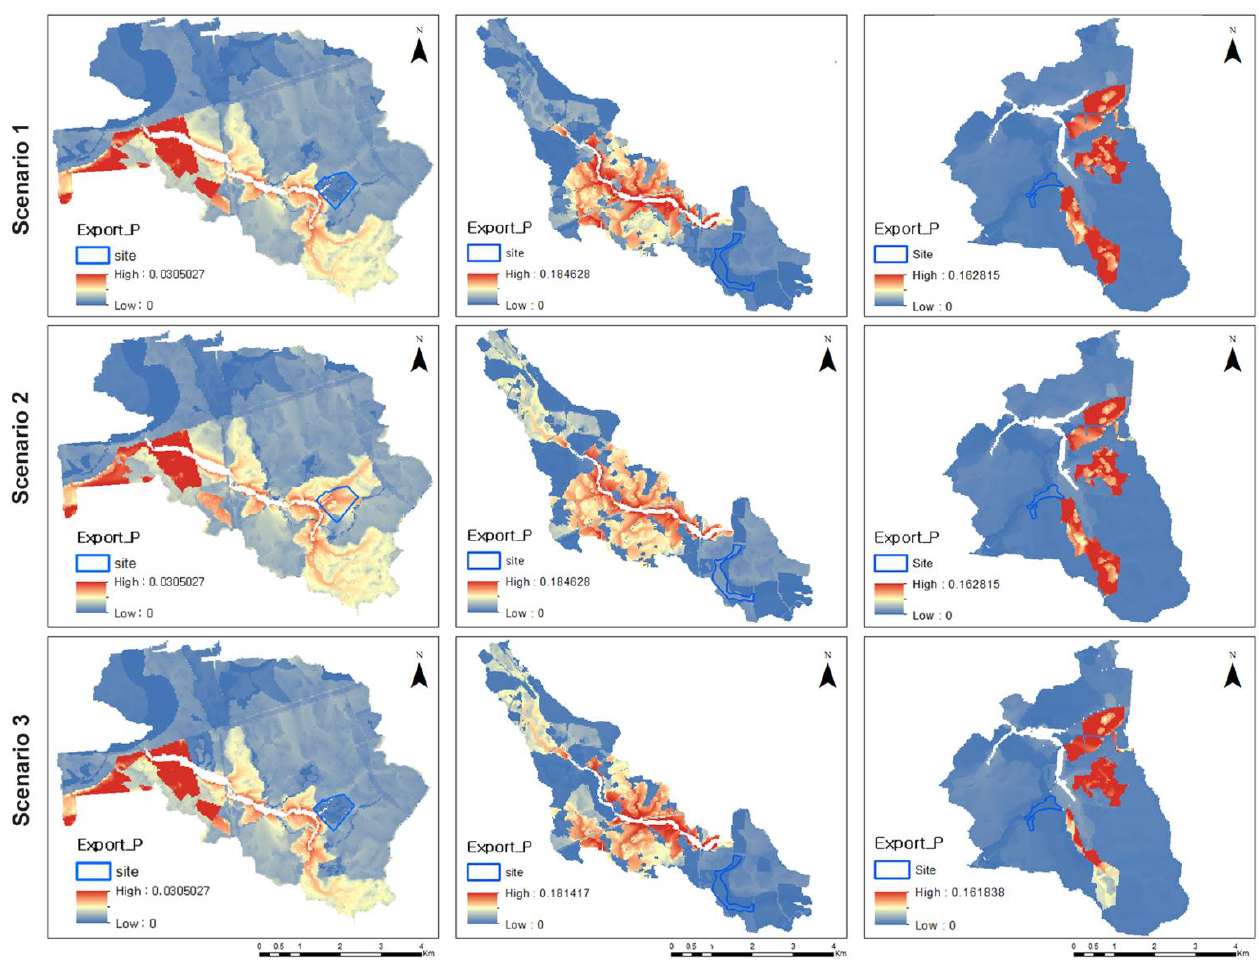
Figure 5. Spatial distribution of the phosphorus load of each study area. Table 5. Runoff NDR model of nutrient (N and P) export (Unit: